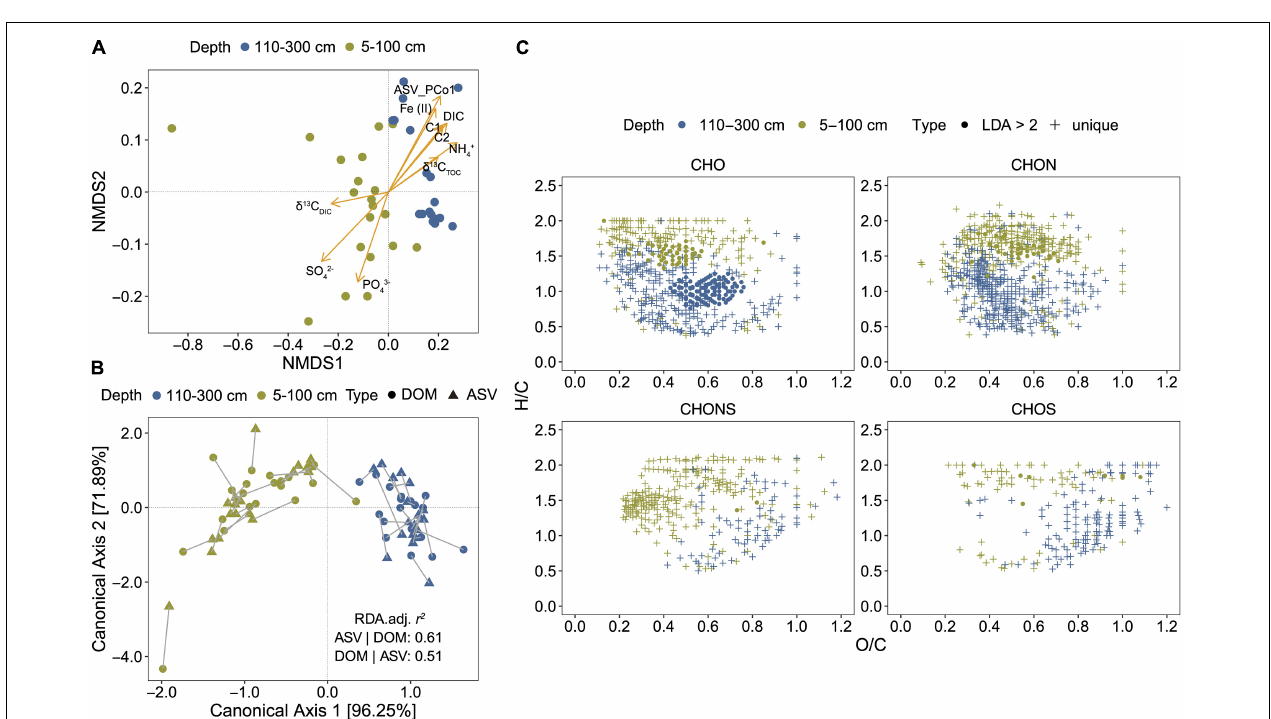
FIGURE 2 | Stratification of DOM composition and its association with environmental drivers and microbial community. (A) Non-metric multidimensional scaling (NMDS) of DOM composition (matrix: Bray-Curtis, stress = 0.0222). ASV, amplicon sequence variant. ASV_PCo1 represents the first principal coordinate axis of microbial community. (B) Canonical correlation analysis (CCorA) conducted using first five principal coordinate (PCo1–5) axes of DOM composition and microbial community. The lengths of connecting lines represent the dissimilarities of two datasets. (C) DOM molecules unique in the upper or deep layers and different between them; different molecules were identified by Linear discriminant analysis (LDA) effect size (LEfSe) with a threshold of LDA > 2. Solid circles represent LDA > 2 and cross symbols represent compounds unique to the upper (5–100 cm) or the deeper (110–300 cm).